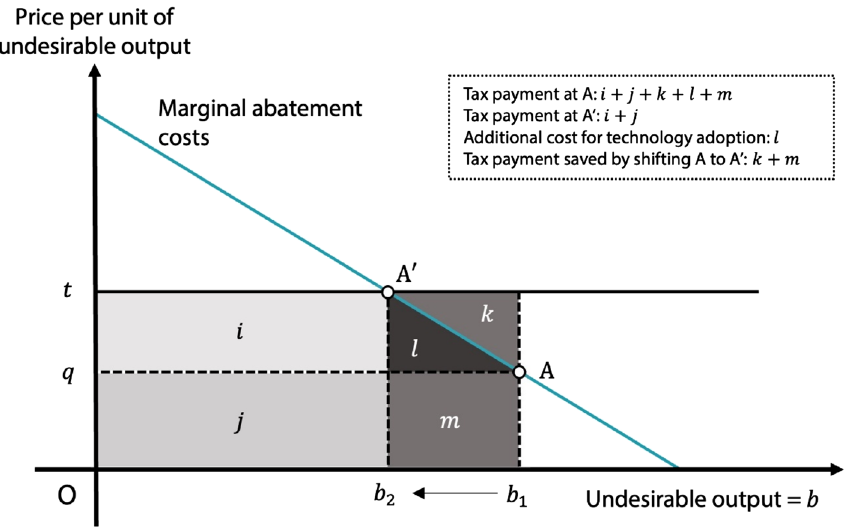
Figure 1. Structure of emission abatement